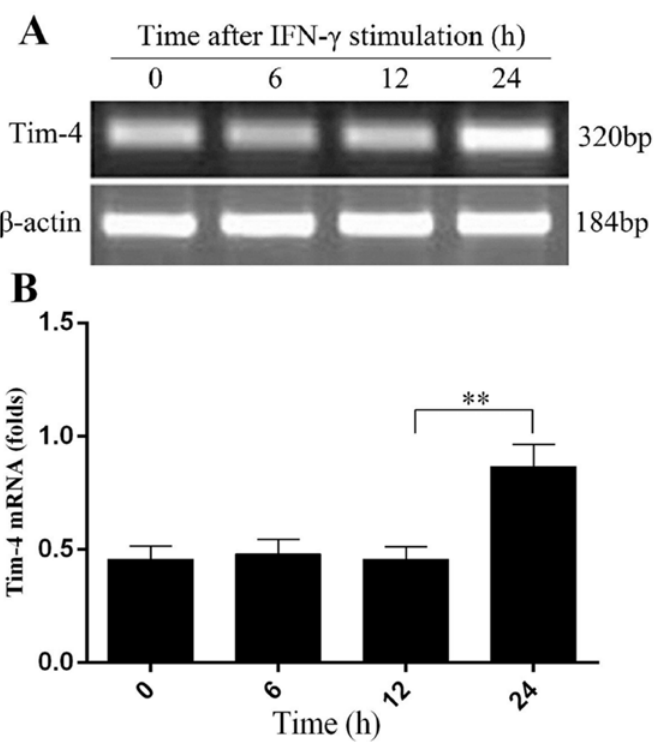
Fig 1. Up-regulation of Tim-4 mRNA in peritoneal macrophages after IFN- γ stimulation. Peritoneal macrophages were isolated from BALB/c mice and then stimulated with 100 U/ml IFN- γ for the time indicated and Tim-4 mRNA levels were determined by RT-PCR (A and B). In all panels, error bars represent the standard deviation from 4 independent cultures. A p value (student ’ s t- test) relative to the control cells of less than 0.01 is indicated by **